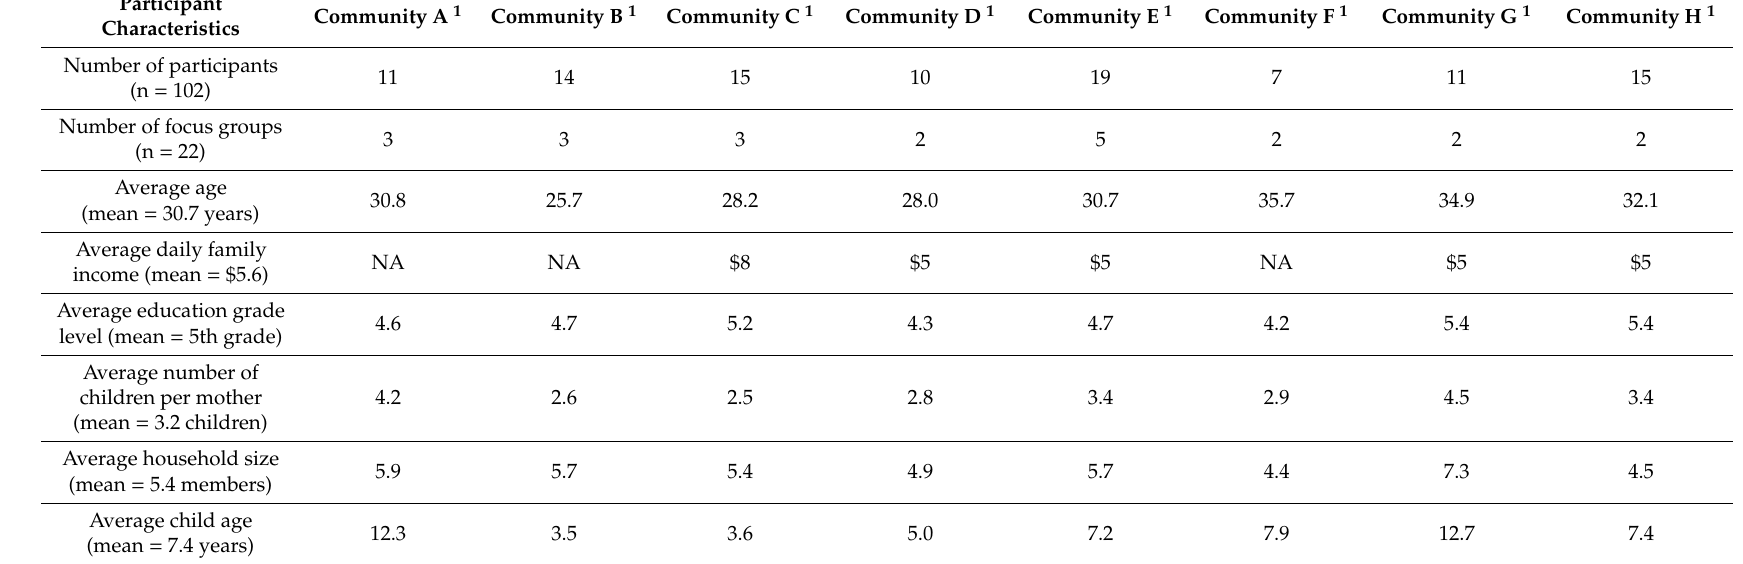
Table 1. Participant Demographic